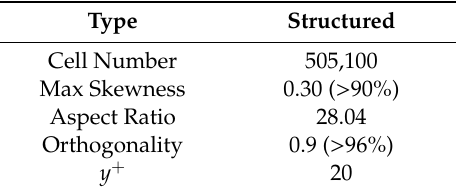
Figure 4. ( a ) Mean tangential velocity profile from Reynolds stress model (RSM) simulation on four different grid sizes at 60 mm from hydrocyclone Hsieh top, ( b ) Mean axial velocity profile from RSM simulation on four different grid sizes at 60 mm from hydrocyclone Hsieh top. Table 2. Mesh quality